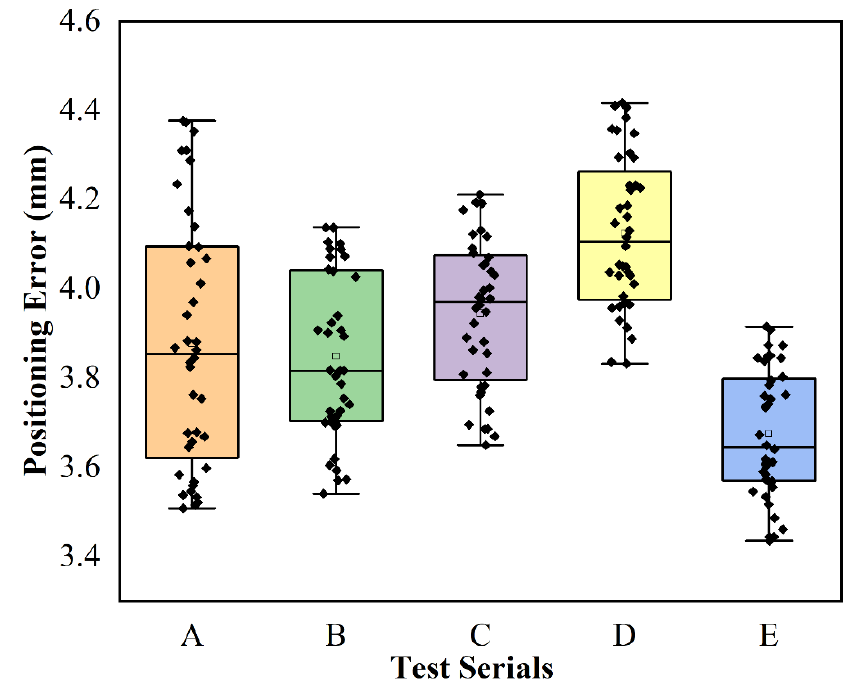
Figure 11. Accuracy test results of the hand–eye